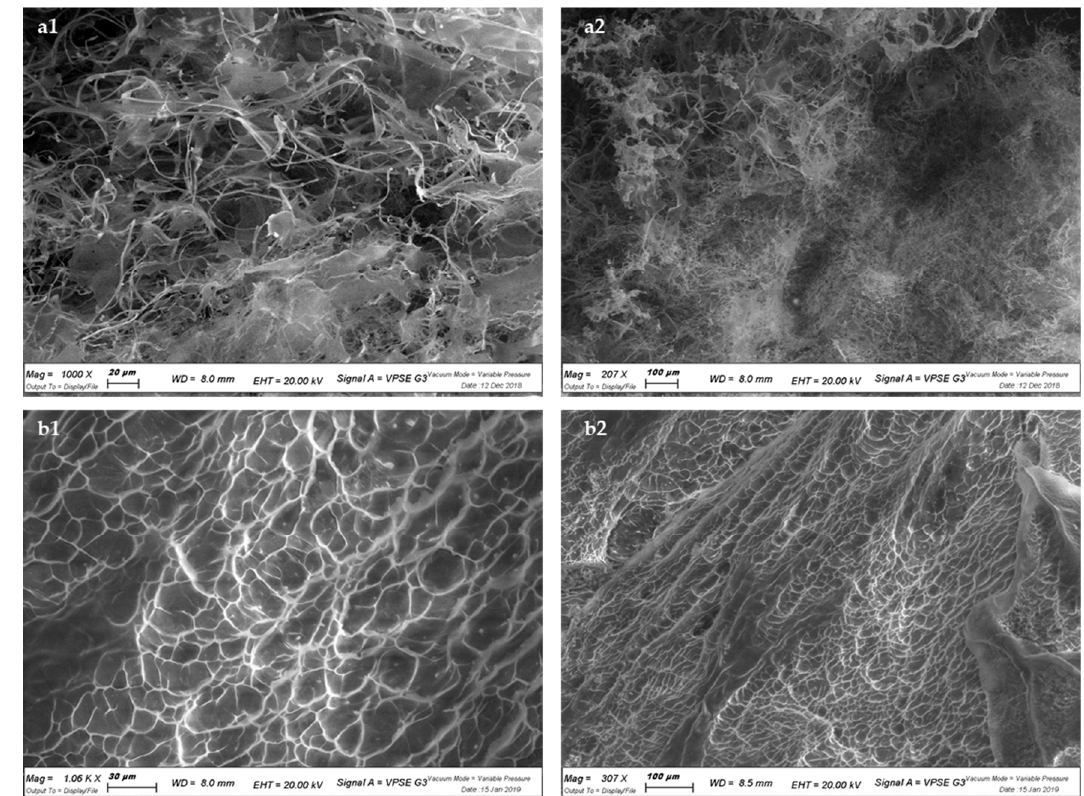
Figure 5. SEM images of HA (panels a1 , a2 ) and HA–Orn (panels b1 , b2 ). SEM Scale bar: 20 μ m (panel a1 ), 100 μ m (panels a2 , b2 ), 30 μ m (panel b1 ).